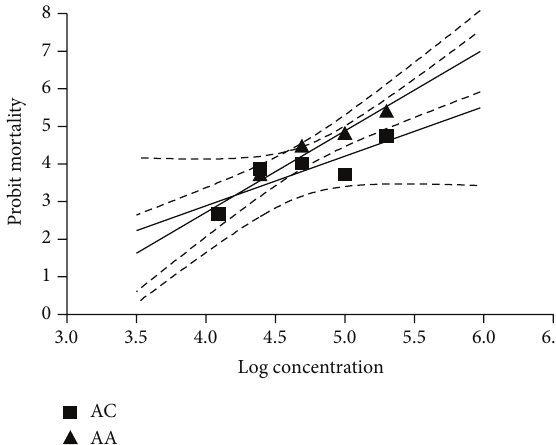
Figure 2: Regression line of probit mortality of R. microplus against thelogconcentrationsoftheethanolicextractsof A.conyzoides (AC) and A. absinthium (AA) using